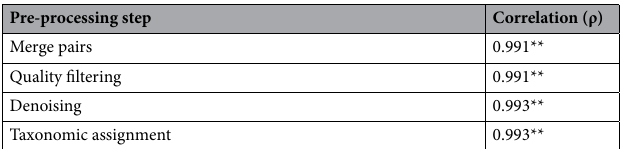
Table 1. Spearman’s correlations (ρ) on the number of sequence read per sample in each pre-processing step between iSeq and MiSeq. **Correlation test, P < 0.01.